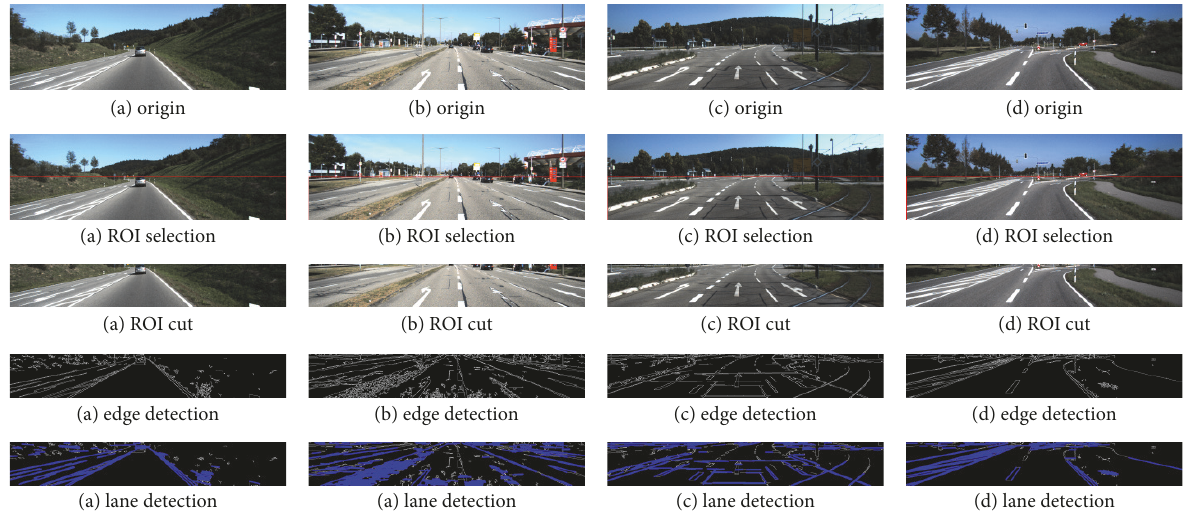
Figure 19: ROI selection and lane detection of sample frames (a), (b), (c), and (d).